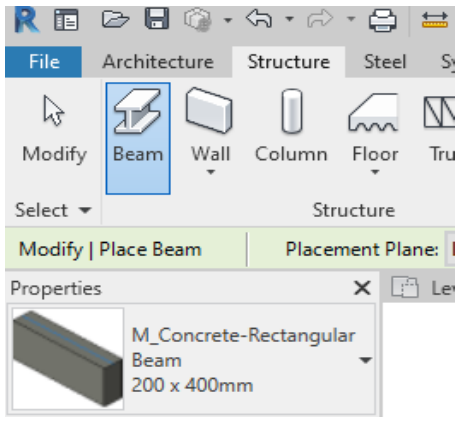
Figure A1. Creation of a basic construction element in Revit TM .